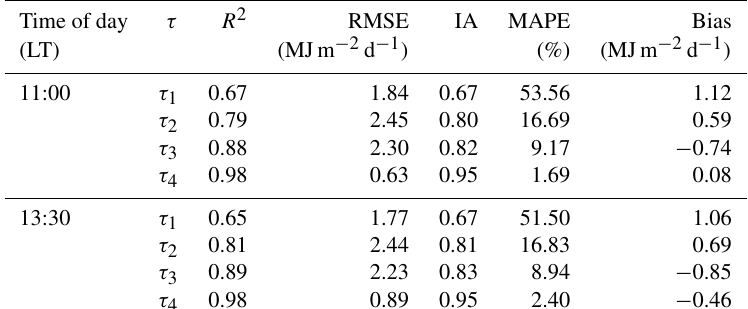
Table 1. Statistical analysis of the performance of ANN in predicting R Sd under varying sky conditions represented by four different classes of daily atmospheric transmissivity ( τ) . Here the statistical metrics of R Sd_pred for two different upscaling hours (11:00 and 13:30LT) are presented.